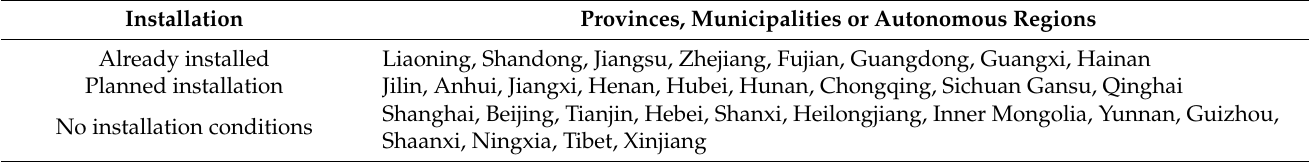
Table A2. Installed potential of nuclear power in each province.